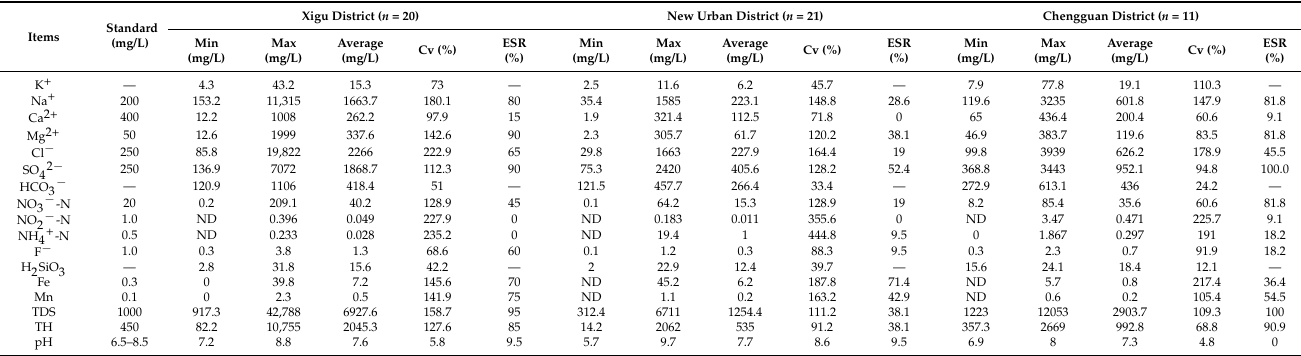
Table 1. Chemical composition of the groundwater in study area in 2012.